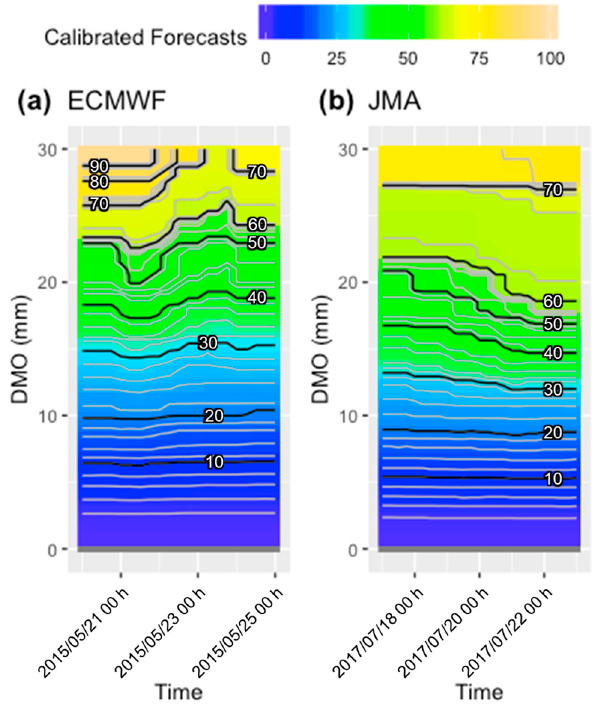
Figure 5. Calibrated values which would be obtained given different DMO values at different time by the Sliding Window method covering the two episodes of abrupt changes: ( a ) the ECMWF episode from 20 May 2015 12 h to 23 May 2015 18 h, and ( b ) the JMA episode from 17 July 2017 12 h to 22 July 2017 00 h. Grey and black contours are in intervals of 2 and 10 mm respectively, starting from 0 mm at the bottom.